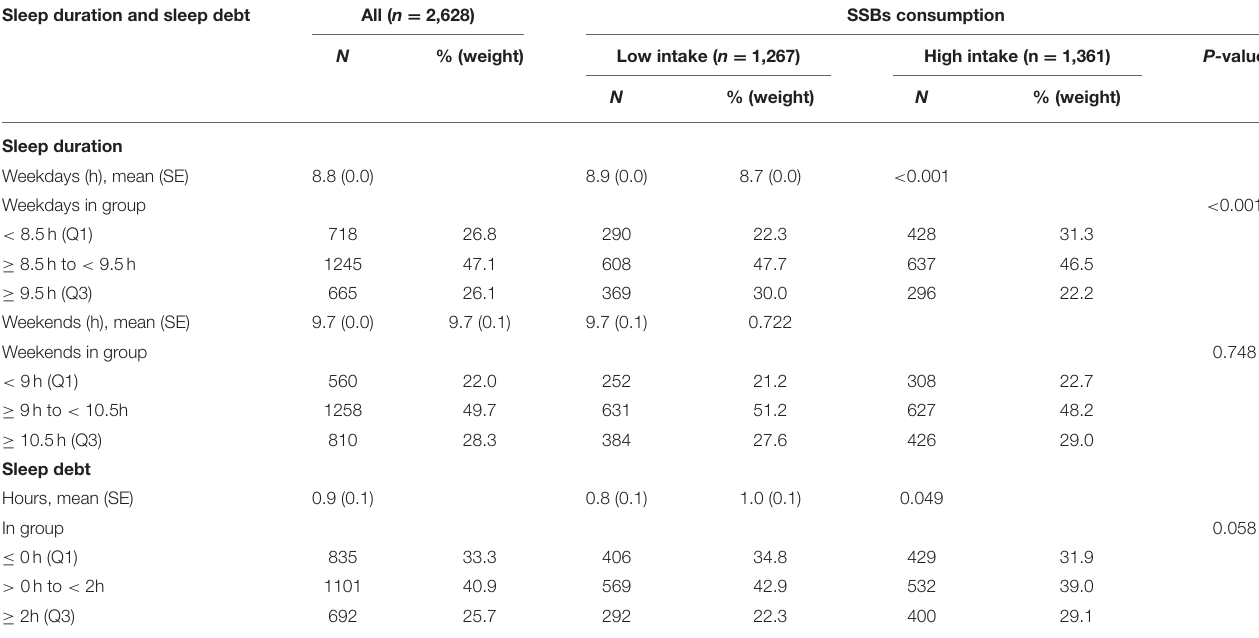
TABLE 2 | Distribution of participants by sleep pattern, including sleep duration on weekdays, sleep duration on weekends, and sleep debt, and SSBs consumption. Sleep duration and sleep